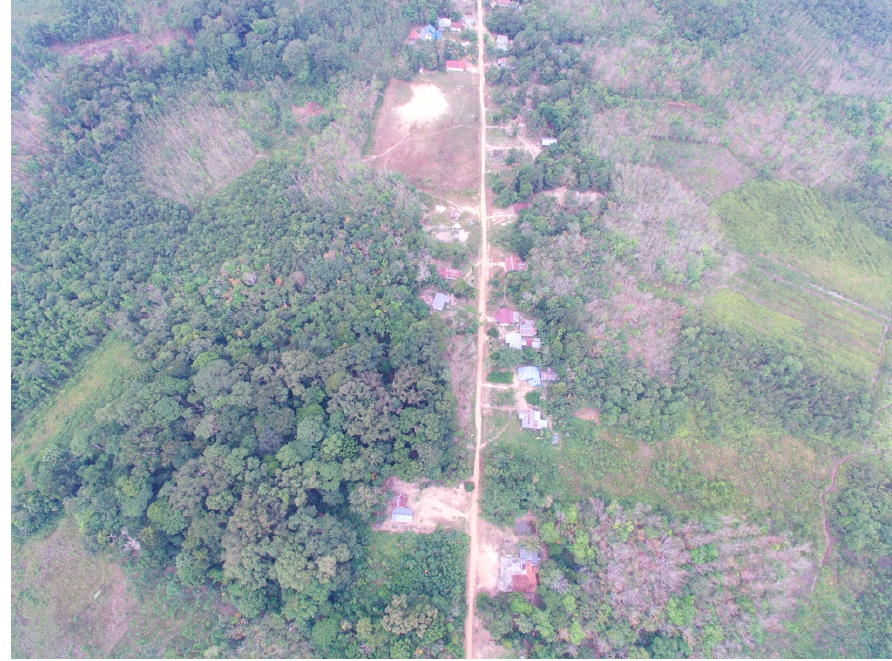
Figure 3. The village maintains adat-managed forests, which lie adjacent to the end of their road. The beginning of the forest can be seen in the left lower hand of the image.